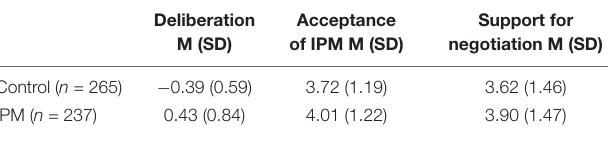
Deliberation Acceptance Support for M (SD) of IPM M (SD) negotiation M (SD)